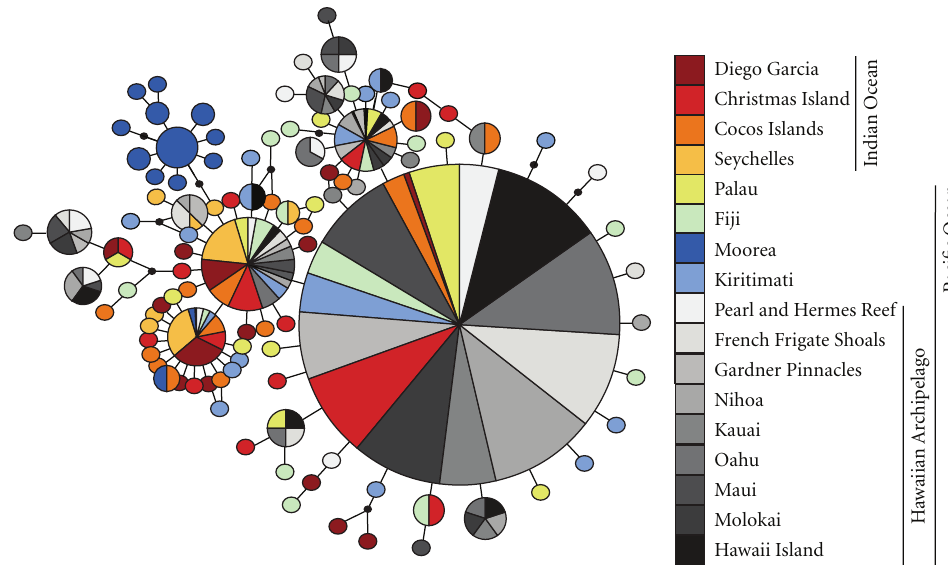
Figure 2: Statistical parsimony network for the Brown Surgeonfish. Area of circles is proportional to the frequency of the respective haplotype. Black dots represent missing haplotypes and colors represent haplotype location (see key). Table 2: Structural analysis of molecular variance ( Samova ) with maximally di ff erentiated groupings for ( K = 1 to 3) and percent variation (%Var.) and fixation indices ( Φ ). Significance represented by: ‡ P ≤ . 001. Among Among groups Among samples within groups Number of Groupings samples groups Φ Φ CT %Var. SC